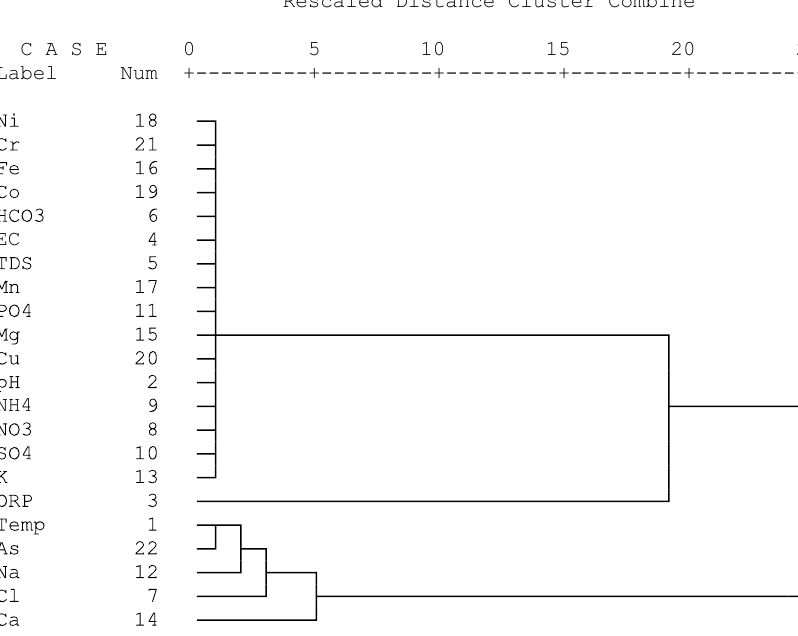
Fig. 3 Hierarchical dendrogram of pre-monsoon data